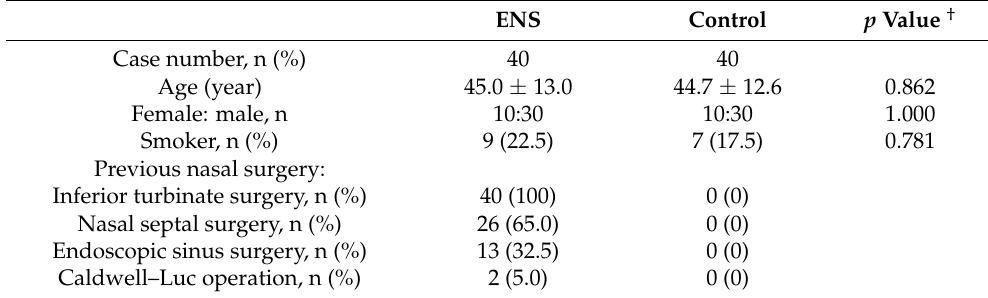
Table 1. Clinical characteristics of the study participants.